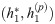
Comparison of hierarchies of military-like RSBMs.The parameters are p = 0.5, q = 0, R = 32, s varies in [0, smax], with smax = 0.0294, and each point refers to a single realisation of the ensemble. The circles represent the pairs (h1*,h1(p)), i.e. the optimal hierarchy h1* computed with agony and the one of the planted hierarchy h1(p). The stars represent (h1*,h¯1*) where h¯1* is the theoretical hierarchy with the parameters of the SBM estimated via GraphTool.